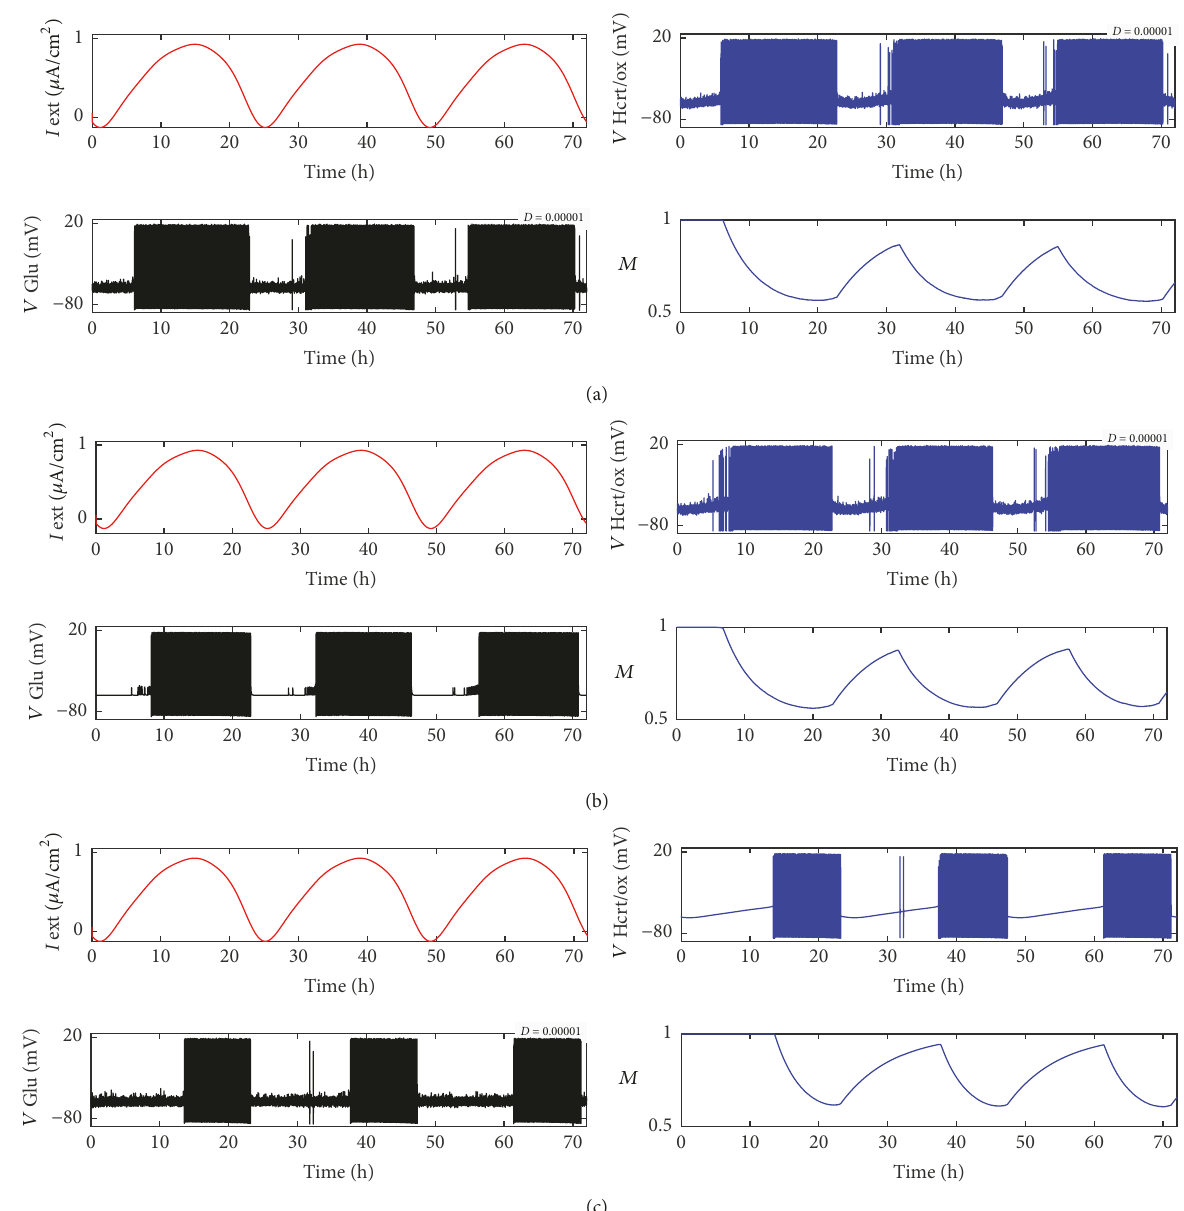
Figure 3: Effects of conductance noise. With the amplitude of external current input still being set to 𝐴 = 0.46 𝜇 A/cm 2 as subthreshold stimulus, the proper noise added to the slow repolarizing variable of two coupled Hcrt/ox and Glu neuron can produce the similar regulation function (a). For the individual noise, the Hcrt/ox neuron’s conductance noise generates more significant effect on the regulation function (b) than the Glu neuron (c). Furthermore, the neurons of sleep-wake cycle model are excited all the time without sleep when noise intensity 𝐷 > 0.00002